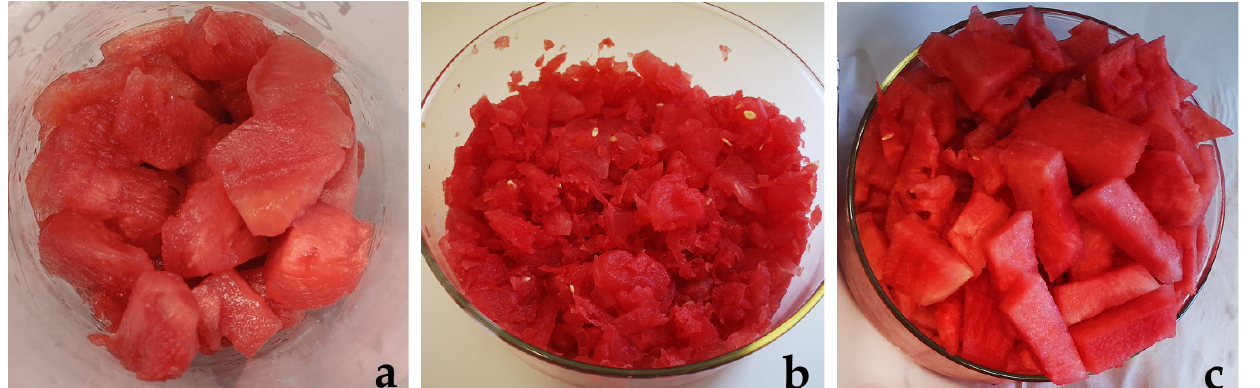
Figure 1. Images of the three watermelon pulps, seeds removed, of ( a ) Gavina ®® ; ( b ) Asahi Miyako ; ( c ) Crimson Sweet .